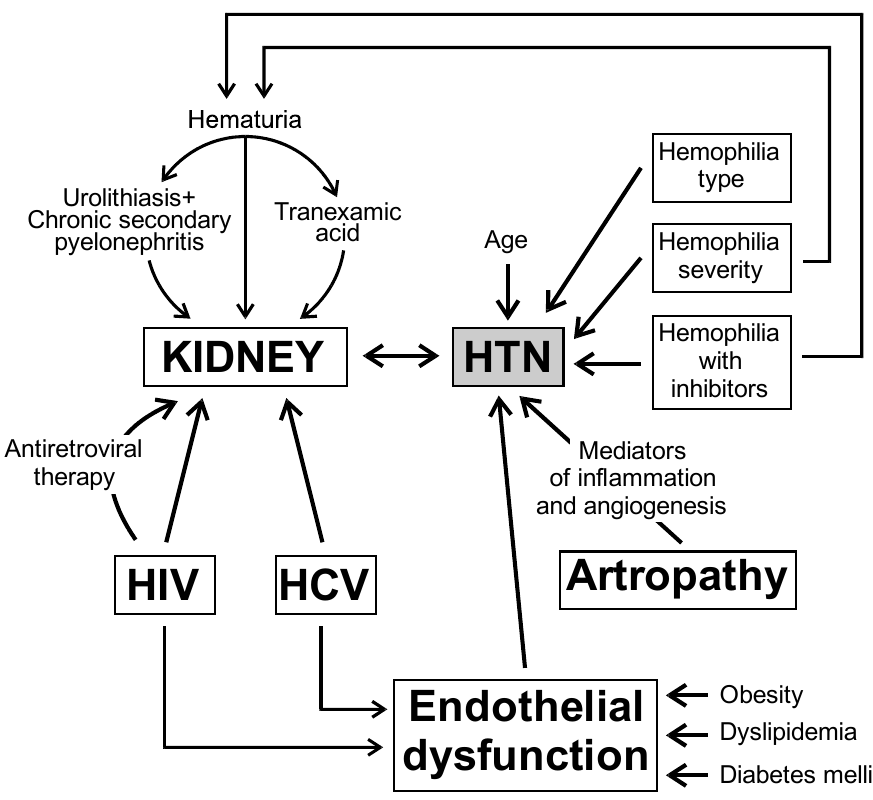
Figure 1. The mechanisms of hypertension in patients with congenital hemophilia.